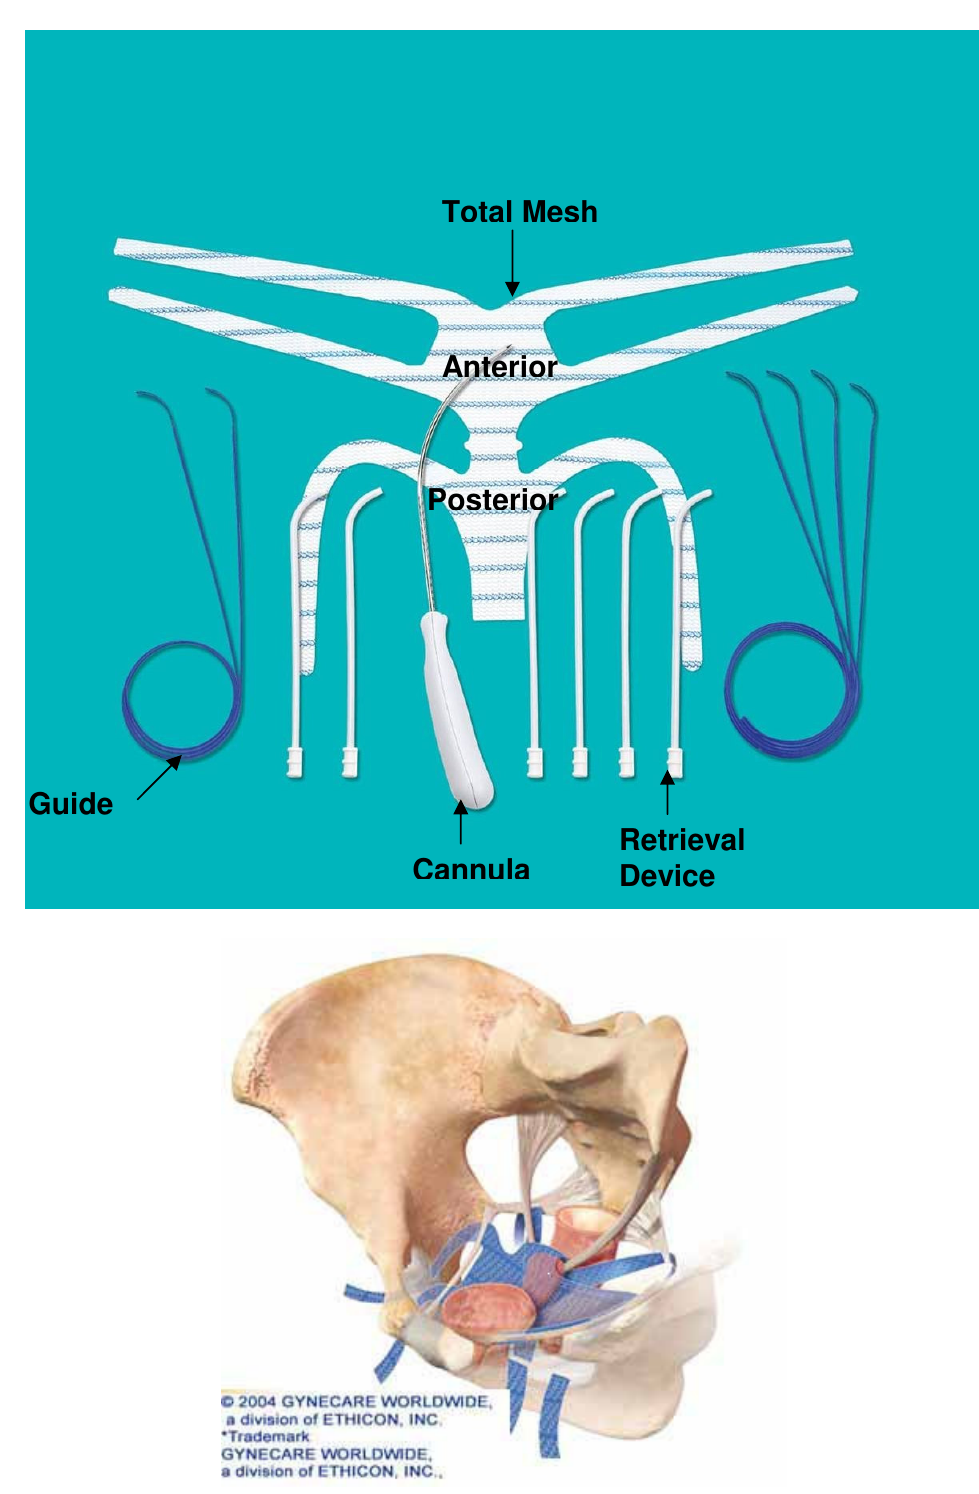
FIGURE 3. Prolift System by Gynecare Worldwide, a division of Ethicon,